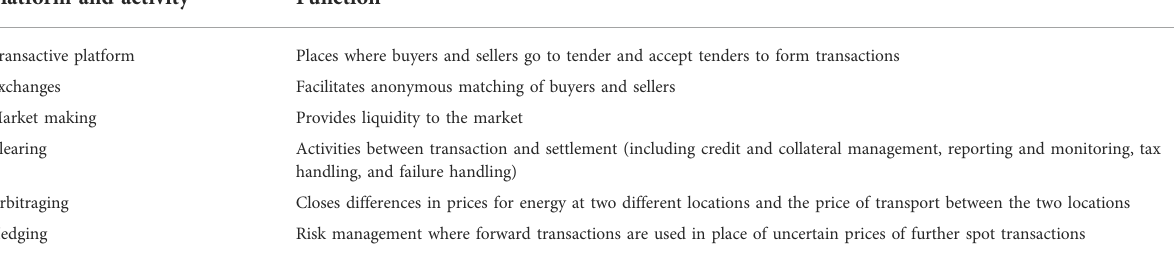
TABLE 3 Activities in the transactive platform (Barrager and Cazalet,